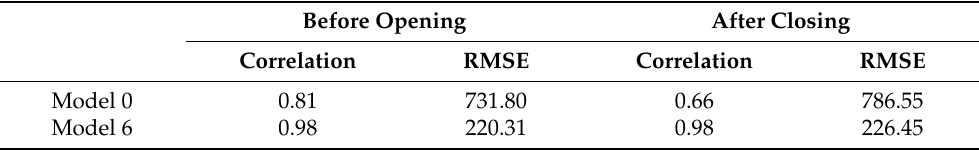
Table 6. Summary of Correlation and